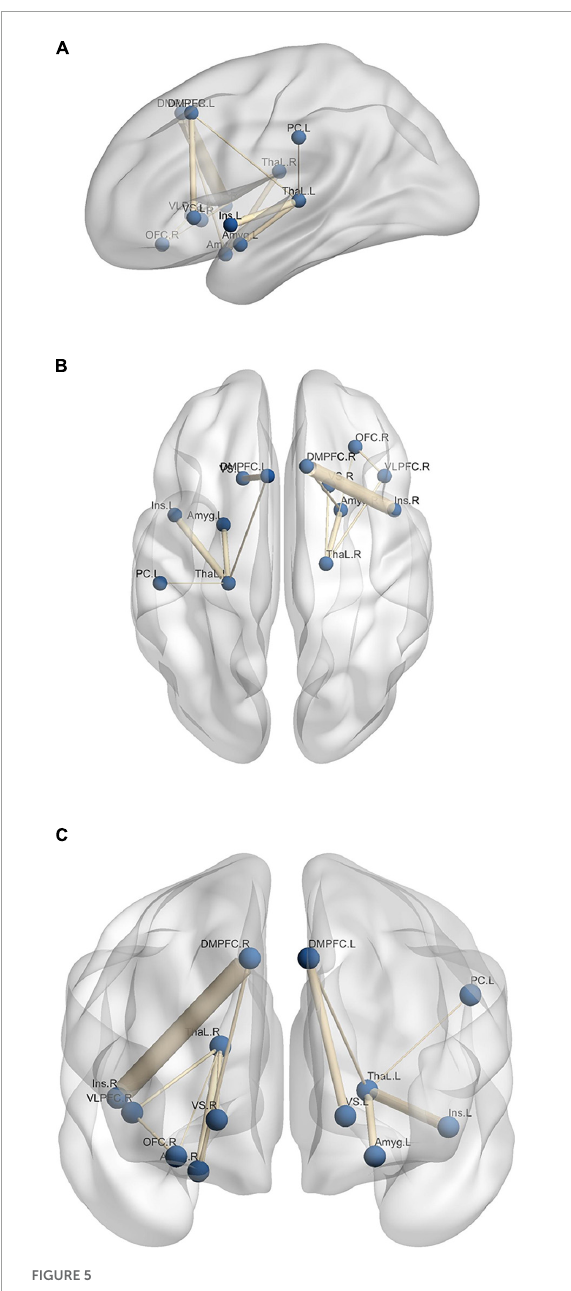
FIGURE5 Significant edges of differential connectivity networks which show network links with significant changes between the Upregulation and View blocks for panel (A) sagittal, (B) axial, and (C) coronal layout. L, left; R, right; Amyg, amygdala; ThaL, thalamus; Ins, insula; OFC, orbitofrontal cortex; VS, ventral striatum; DMPFC, dorsomedial prefrontal cortex; VLPFC, ventrolateral prefrontal cortex; PC,